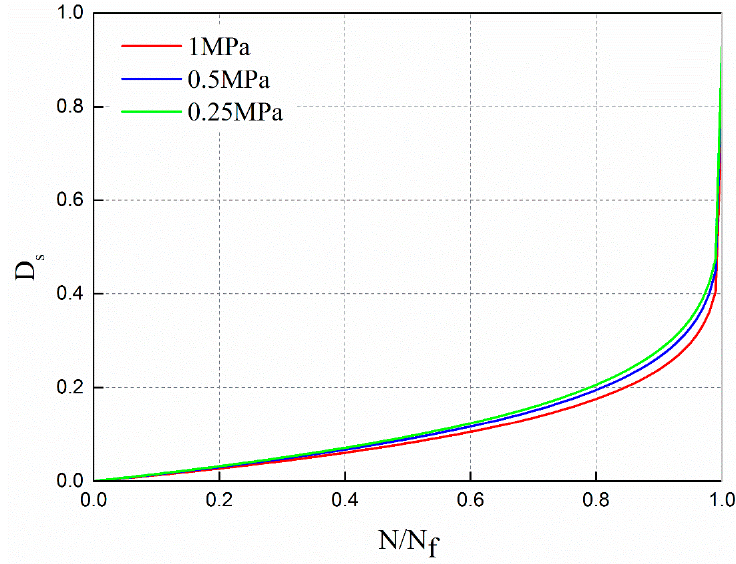
Figure 21. The damage evolution law based on residual strength decay under different stress